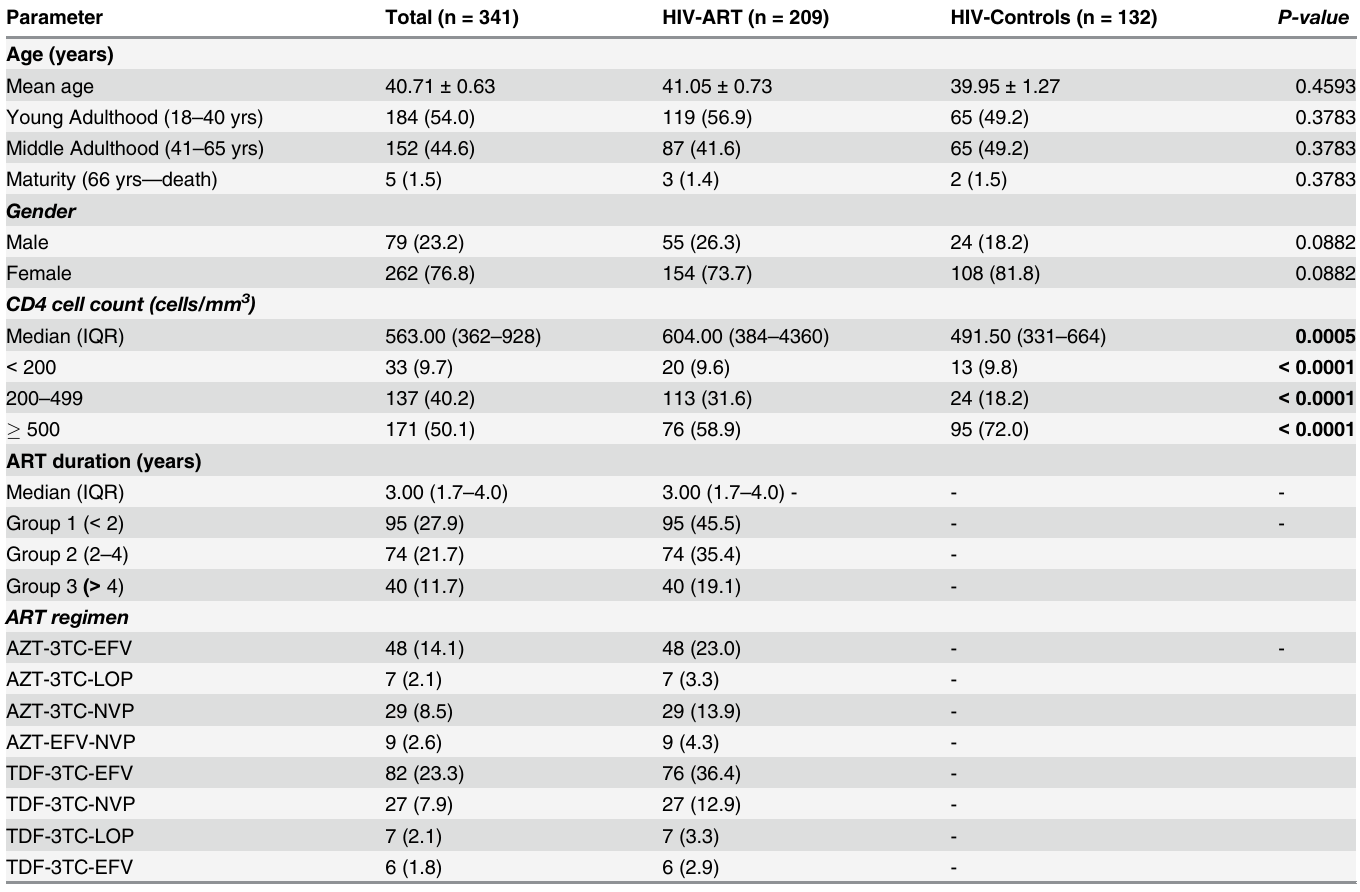
Table 1. Demographic and clinical characteristics of study